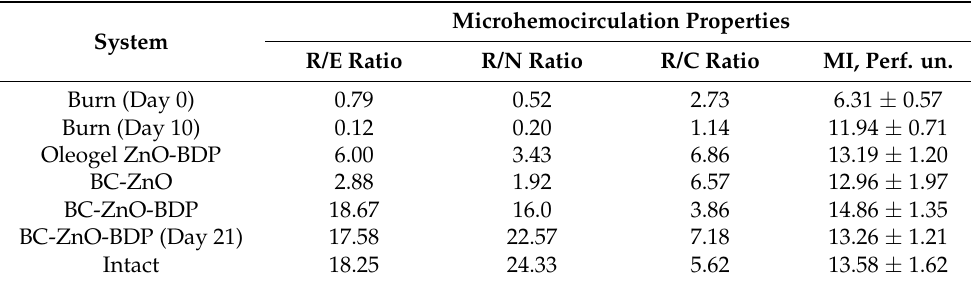
Table 1. Data of the wavelet-LDF spectra obtained on the wound on Day 10 of treatment (Figure 1) 1 .